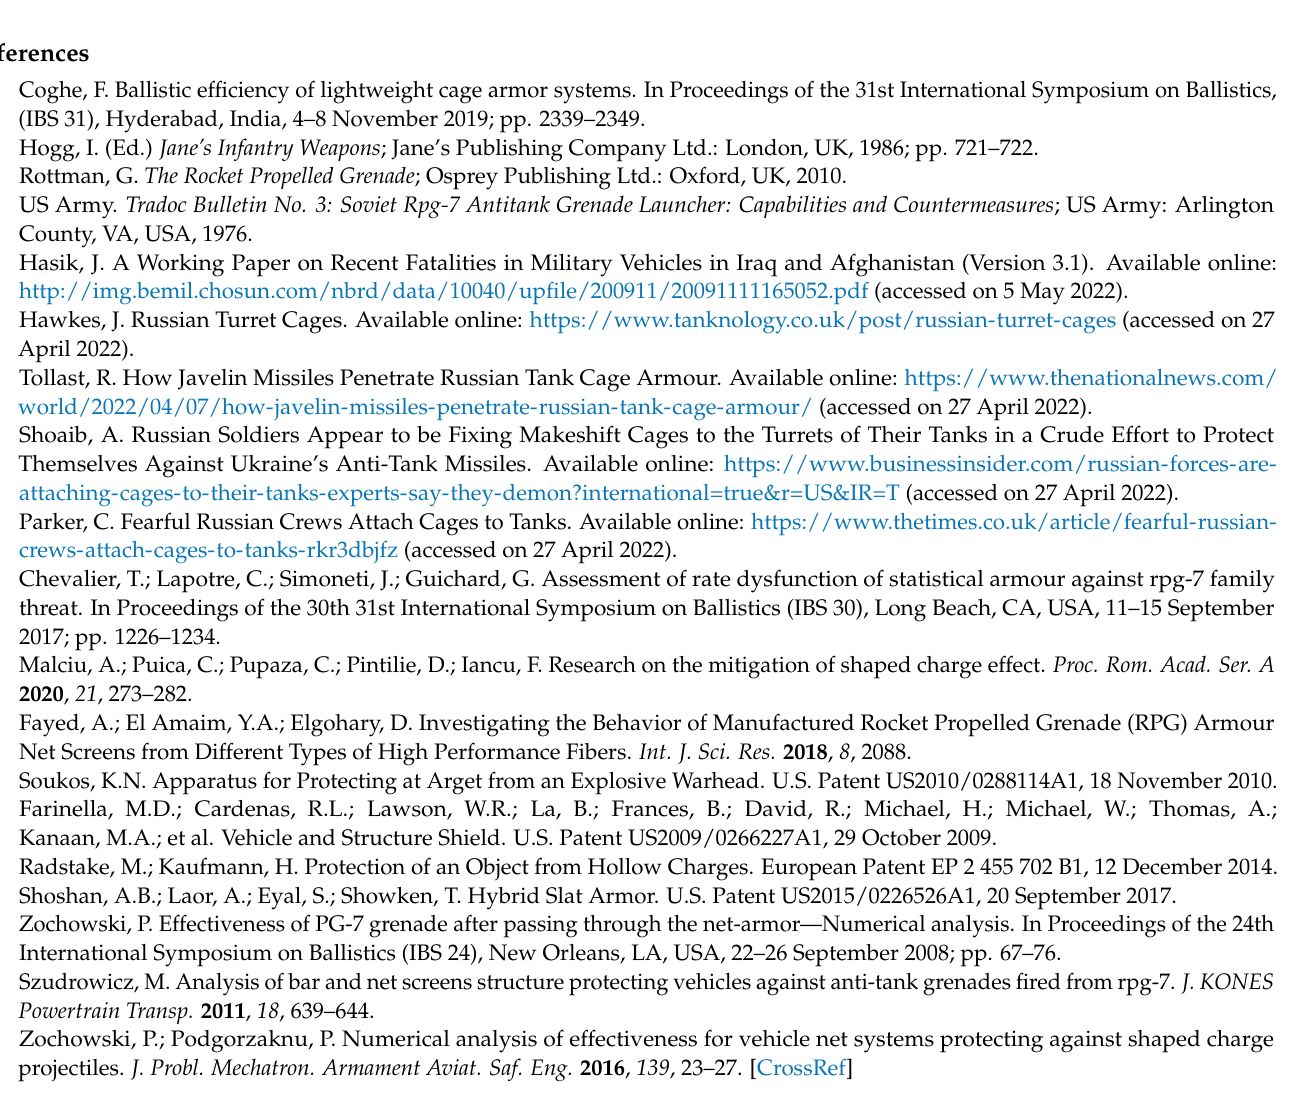
Figure A6. Geometric analysis for the inertial distributed weight cage armour system, taking into account the horizontal and vertical impact angles.